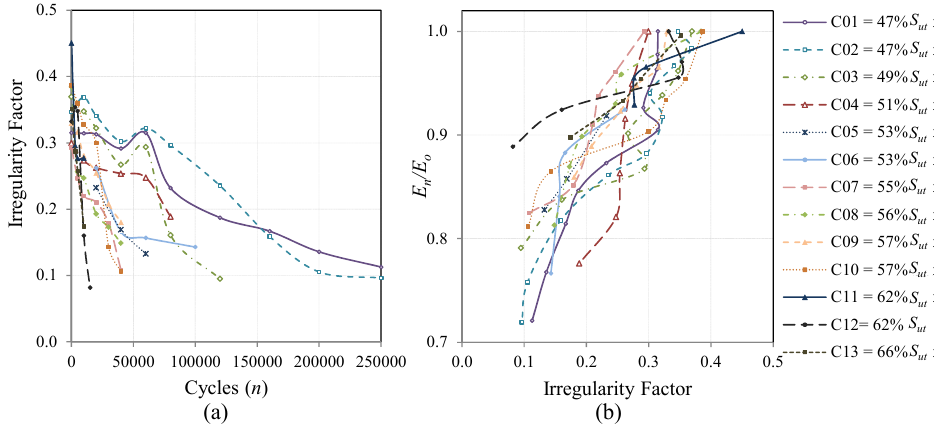
Figure 10. Evolution of the I ‐ Factor of all the coupons cycled with CAL. The shown I ‐ Factor for each coupon is the mean value of the areas of inspection; ( a ) Evolution through the fatigue cycles; ( b ) Relation between the evolution of the stiffness degradation and the evolution of I ‐ Factor. Materials 2015 , 8 , page–page